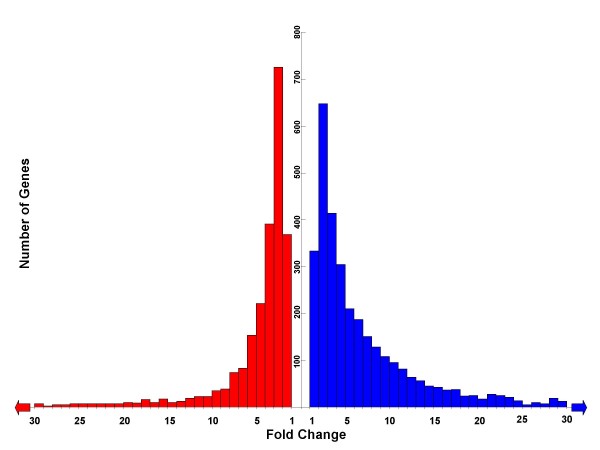
Expression bias for male-enriched genes is greater than expression bias for female-enriched genes. Histogram showing the distributions of fold change values for female-enriched (red) and male-enriched (blue) genes. Recall that our differential expression criteria revealed 2512 female-enriched and 3387 male-enriched genes. Each observation represented in this graph is a mean across four fold change values, corresponding to the four different absolute expression analyses. Arrows at x-axis termini represent distribution tails, which are not shown. These tails (approximately 200 observations each) were omitted for ease of graphical representation, and their absence does not affect the interpretation of the histogram. Comparison of the two distributions reveals that male-enriched genes are more frequent at higher fold change intervals, relative to female-enriched genes, and a Mann-Whitney U test formally confirms higher fold change values for male-enriched genes (p < 0.001).